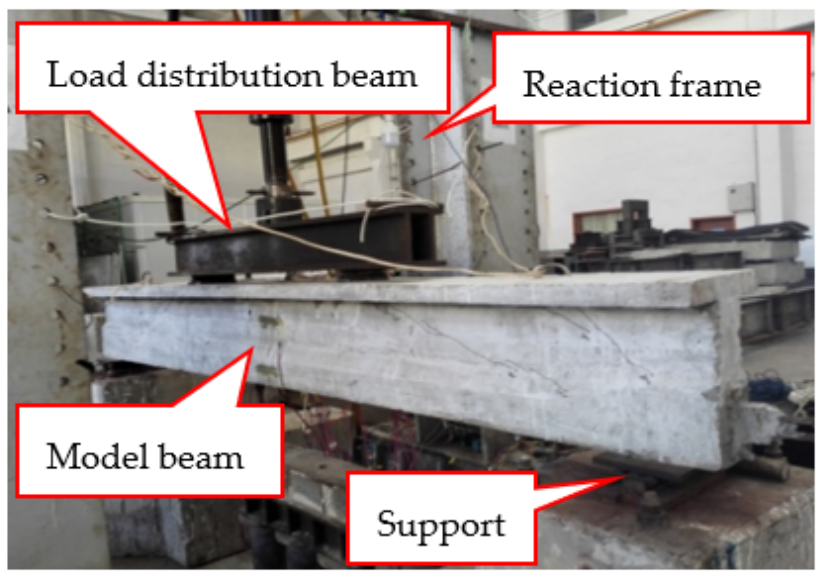
Figure 3. Test setup for the model beam.